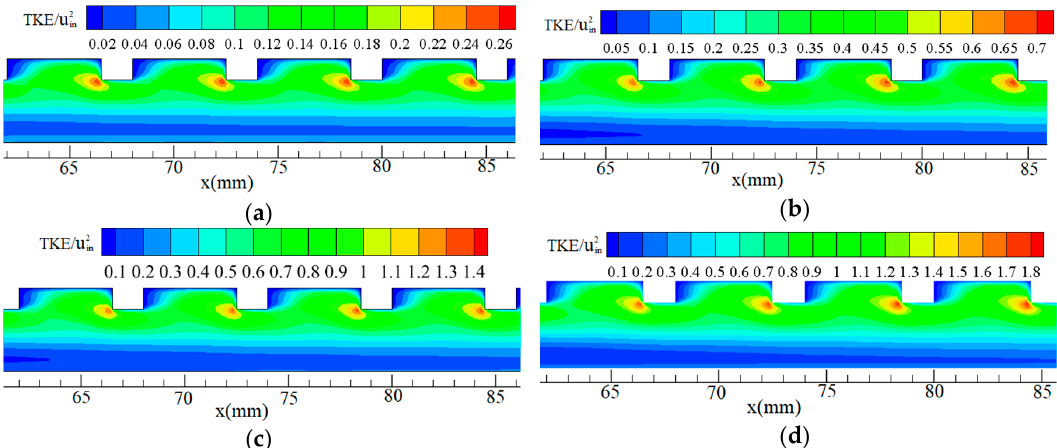
Figure 16. Contours of turbulence kinetic energy (TKE) in a narrow channel under different Reynolds numbers. ( a ) Re = 2250; ( b ) Re = 3750; ( c ) Re = 5250; ( d ) Re = 6000.